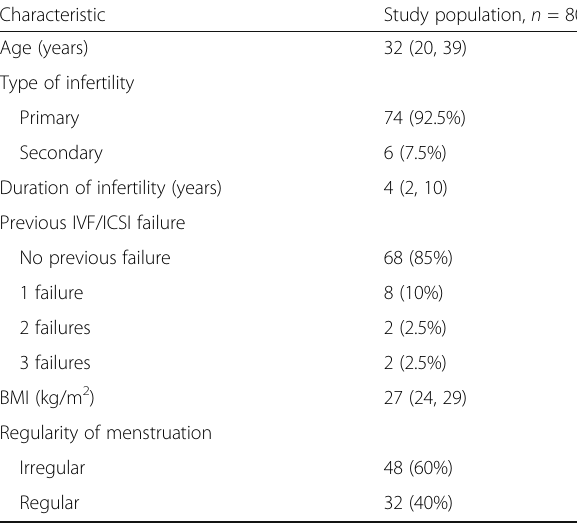
Table 1 General and clinical characteristics of the